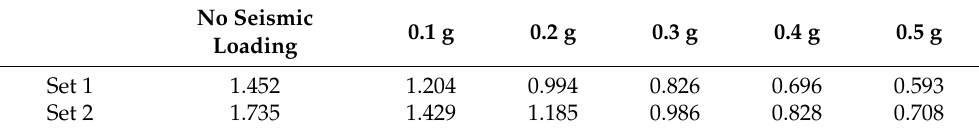
Table 10. The safety factors under different seismic load conditions for both parameter